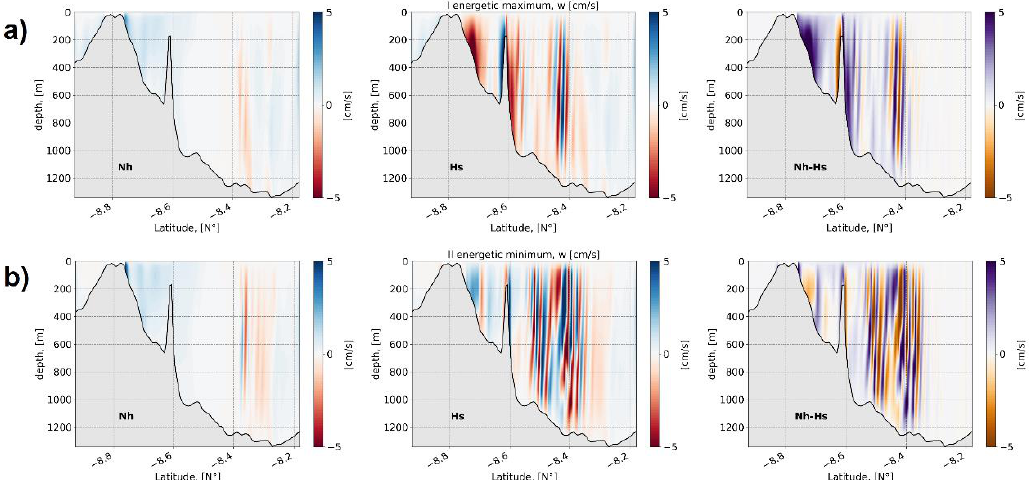
Figure 8. Distribution of vertical velocity in the section along the axis of the Lombok Strait (Figure 2a) in Nh and Hs approaches. ( a ) I energetic maximum; ( b ) II energetic minimum. Left: Nh approach; middle: Hs approach; right: difference between Nh and Hs vertical velocities.